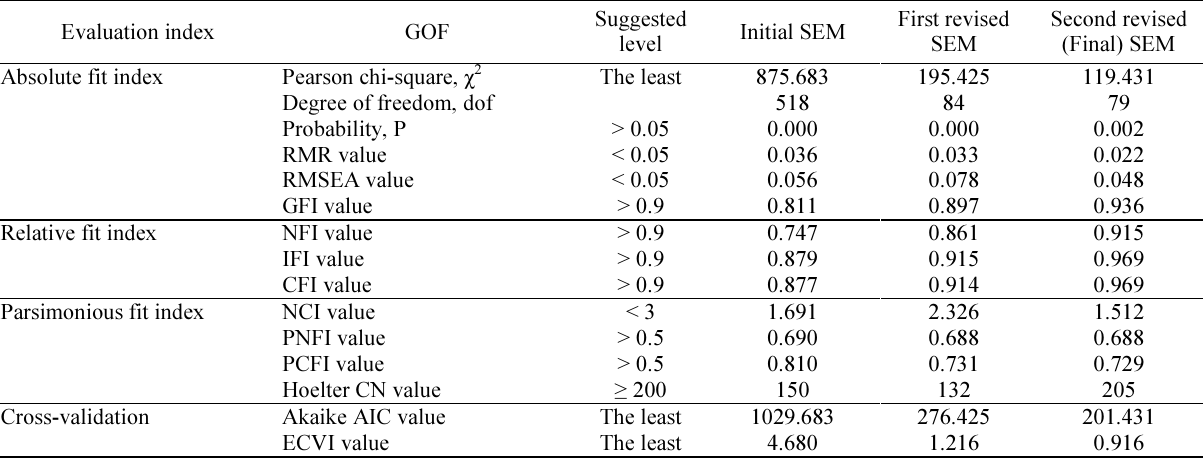
Table 6. Goodness of fit measurement of the SEM framework Evaluation